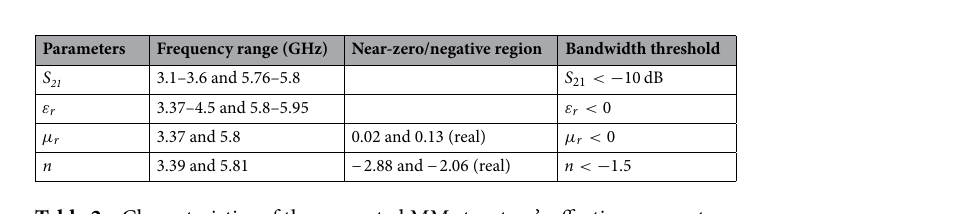
Table 2. Characteristics of the suggested MM structure’s effective